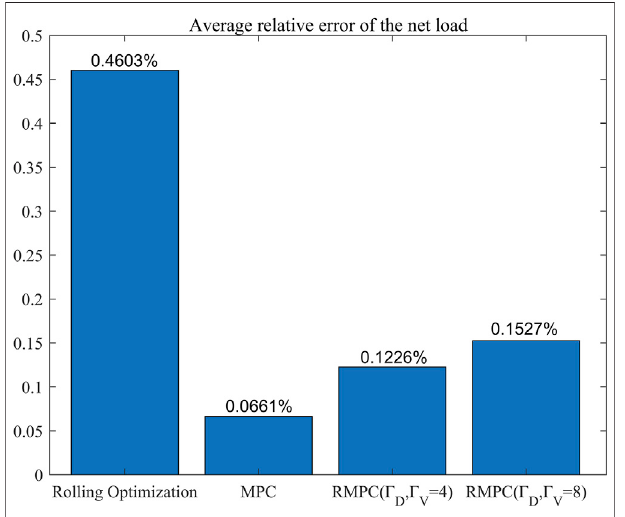
FIGURE 9 | Average relative error of the net load.